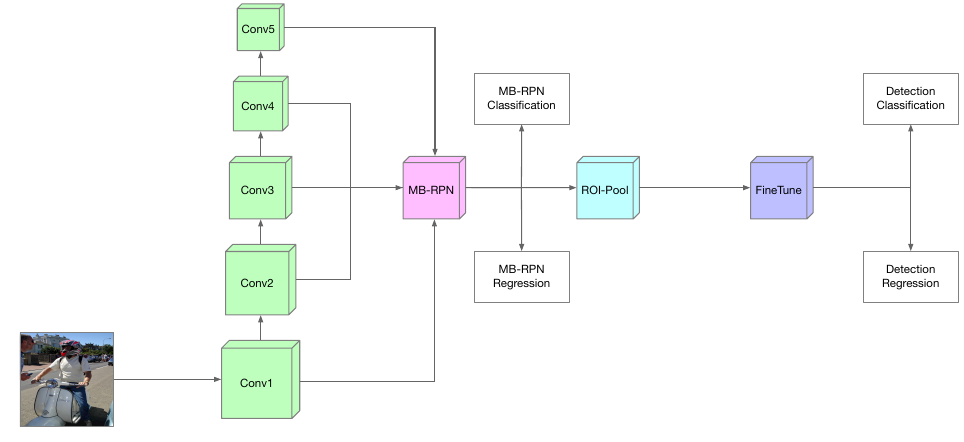
Figure 1. Architecture of Proposed